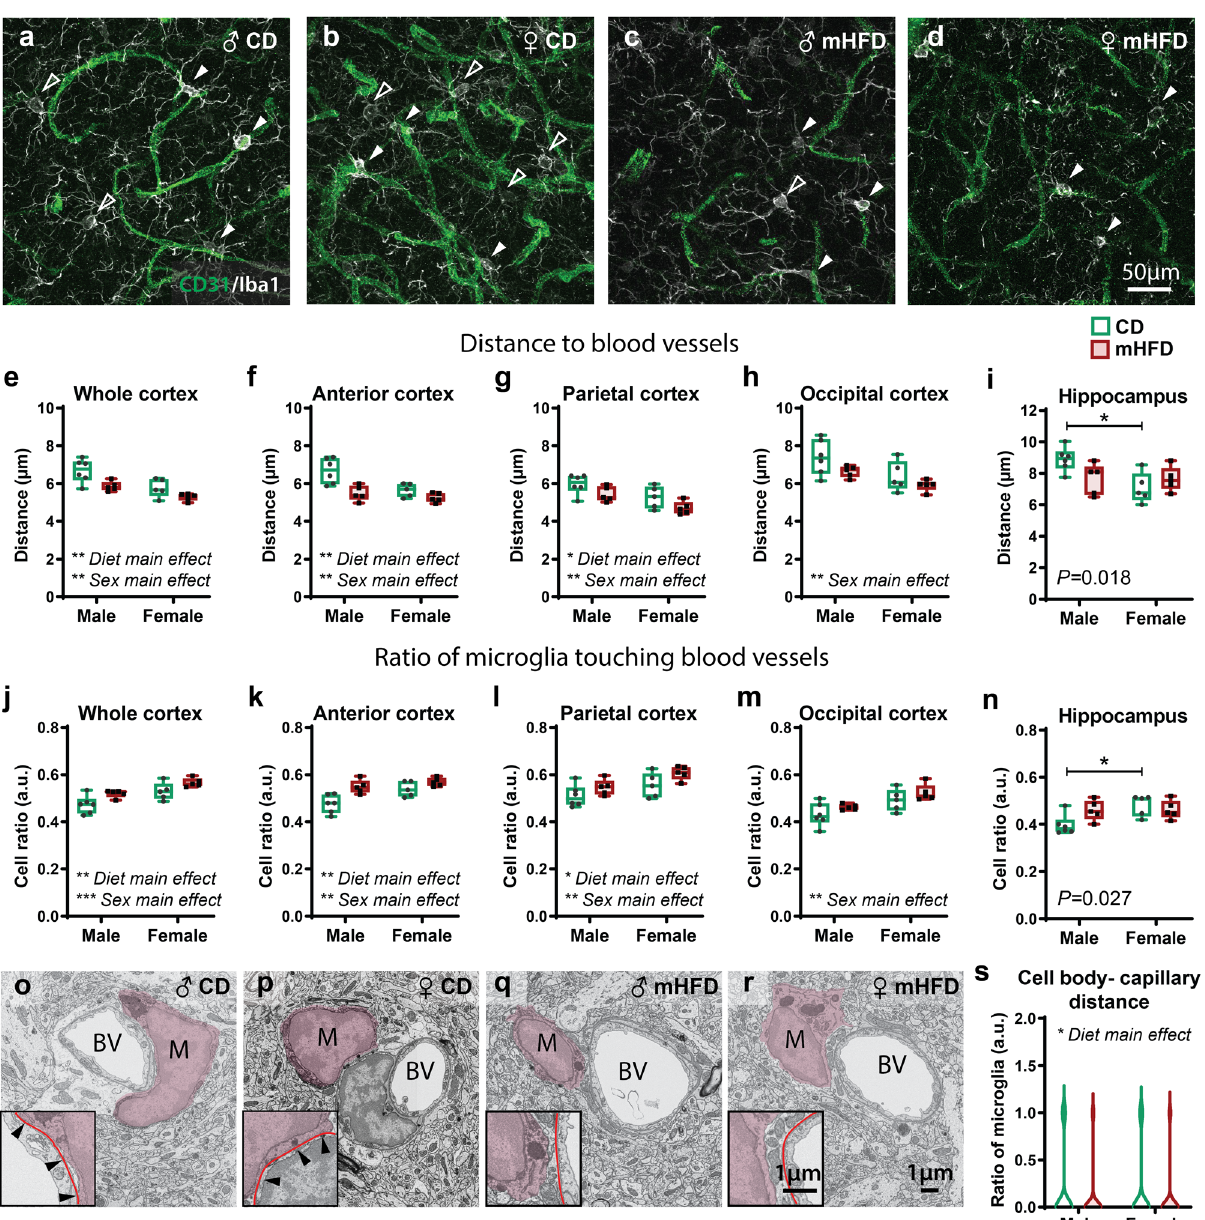
Fig. 2 Microglial distance to blood vessels and their putative contact with blood vessels in P30 offspring are impacted in a region-speci fi c manner. a – d Pictures taken at 63x with a confocal microscope show microglial interaction with blood vessels from the parietal cortex, where microglia making putative contacts ( fi lled white arrowheads) and microglia that are not making putative contacts (open white arrowheads) were identi fi ed. e – i Distance to blood vessels and ( j – n ) ratio of microglia touching blood vessels were calculated for the ( e , j ) whole cortex, ( f , k ) anterior cortex, ( g , l ) parietal cortex, ( h , m ) occipital cortex and ( I , n ) hippocampus of the adolescent offspring ( n = 5 – 6 animals/diet/sex). o – r Micrographs show average distance of microglial cell body (identi fi ed by “ M ” , pseudocoloured in fuchsia) from capillaries (identi fi ed “ BV ” ) of the parietal cortex, where direct contact with the basement membrane (line in red) are indicated by a fi lled black arrowhead. ( s ) Analysis at the nanoscale level revealed reduction of these direct contacts by microglial cell body ( n = 77 – 84 microglia/diet/sex, N = 4 animals/group). Whisker graphs show minimum, median (line) and maximum, as well as individual data points ( n = 5 – 6 animals/diet/sex). Violin graphs show minimum, median (line) and maximum (77 – 84 microglia/diet/sex, N = 4 animals/ group for ultrastructure analysis of microglia). * P < 0.05, ** P < 0.01, *** P < 0.001 by 2-way ANOVA analysis (for cortical regions). * P < 0.05 by 2-way ANOVA analysis followed by Bonferroni post-hoc (for the hippocampus). * P < 0.05 by mixed-effects analysis (for ultrastructure analysis). ♀ : female, ♂ : male, a.u.: arbitrary units, CD: control diet, mHFD: maternal high-fat